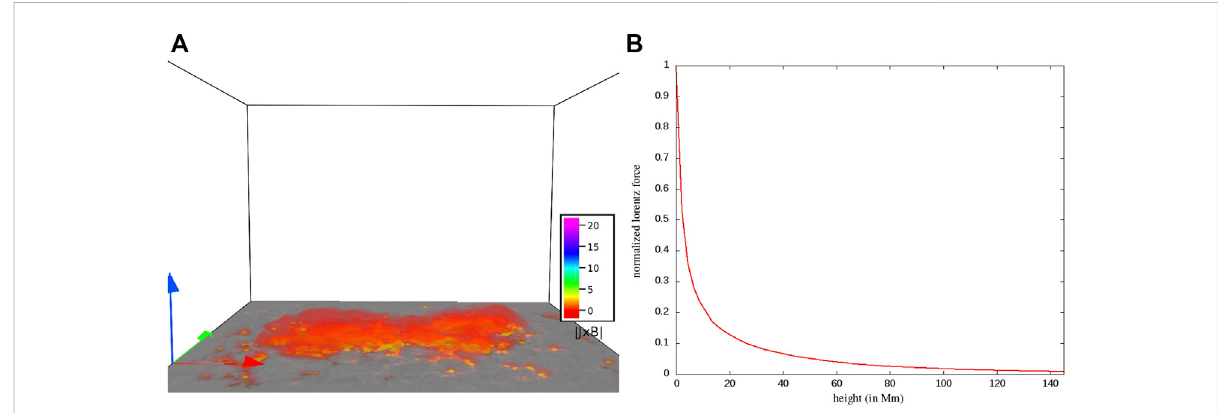
FIGURE 4 Panel (A) shows the distribution of the magnitude of the initial Lorentz force density in the computational domain. Panels (B) depicts the variation of magnitude of the horizontally averaged Lorentz force density with height (Mm). The force density is normalized with respect to its maximum value, as our focus is on its decay rate with height. Both the panels clearly illustrate the exponential decrease of the force density with height.